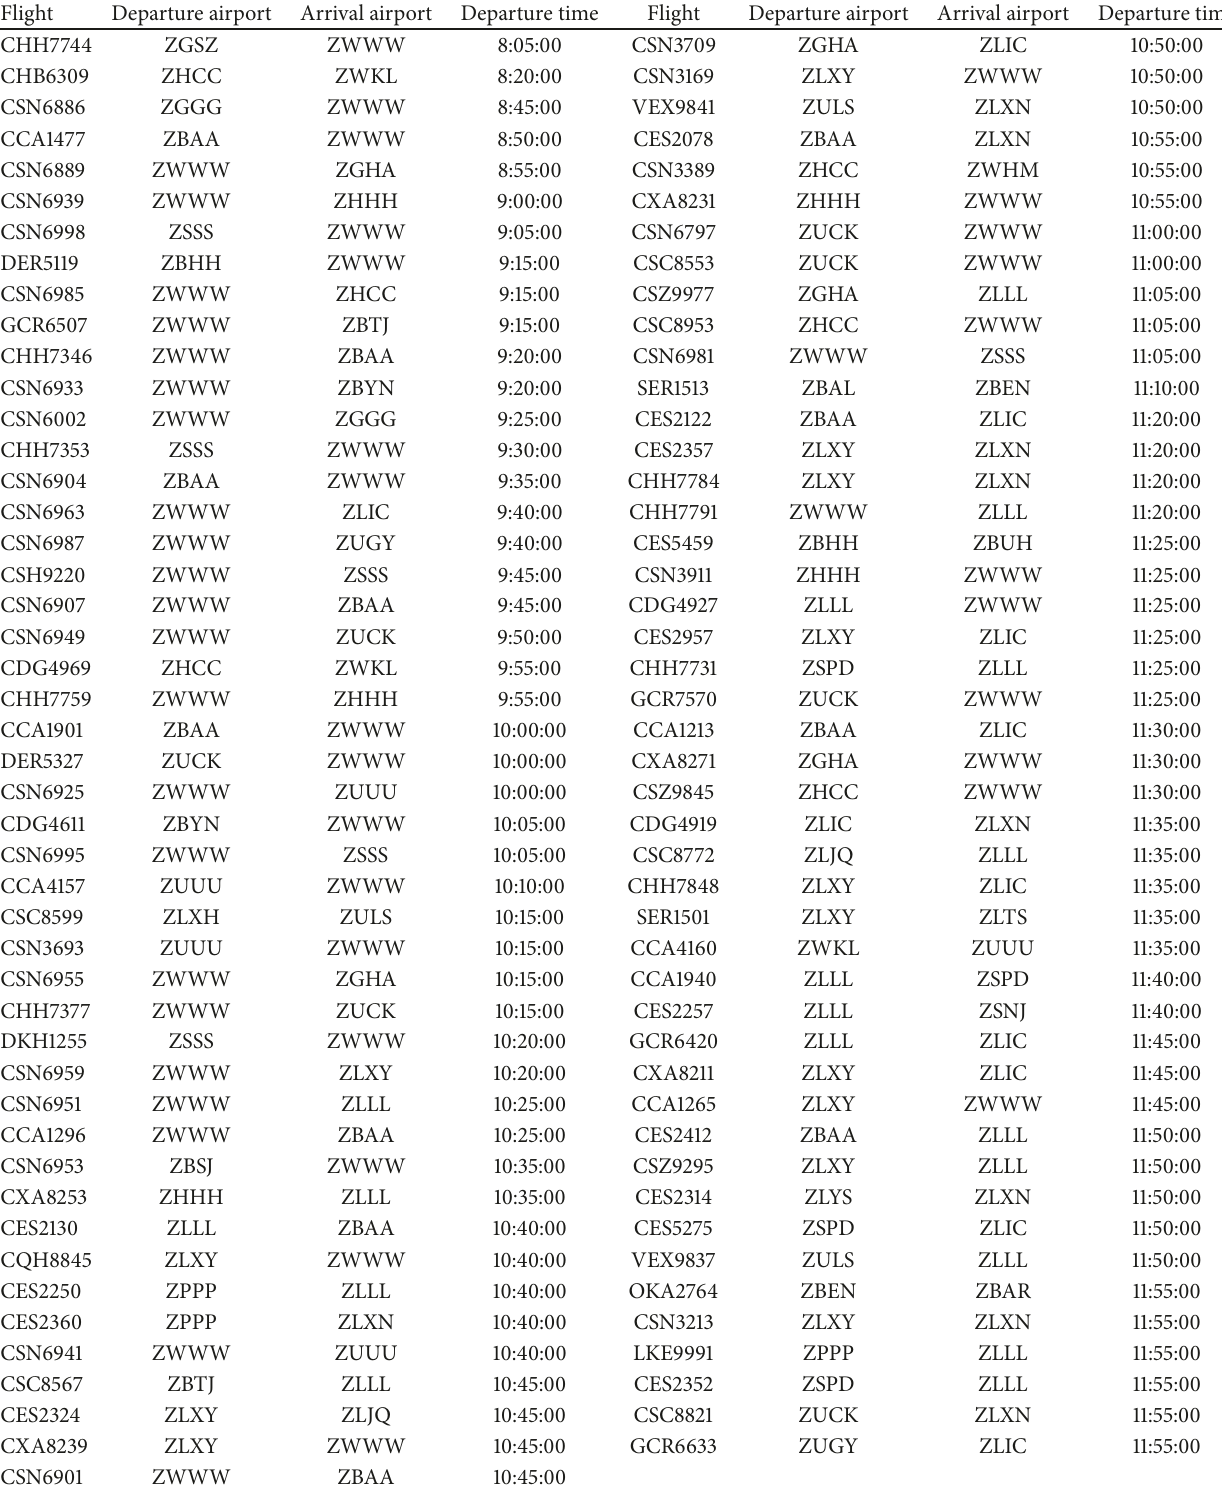
Table 2: The flight schedule for related